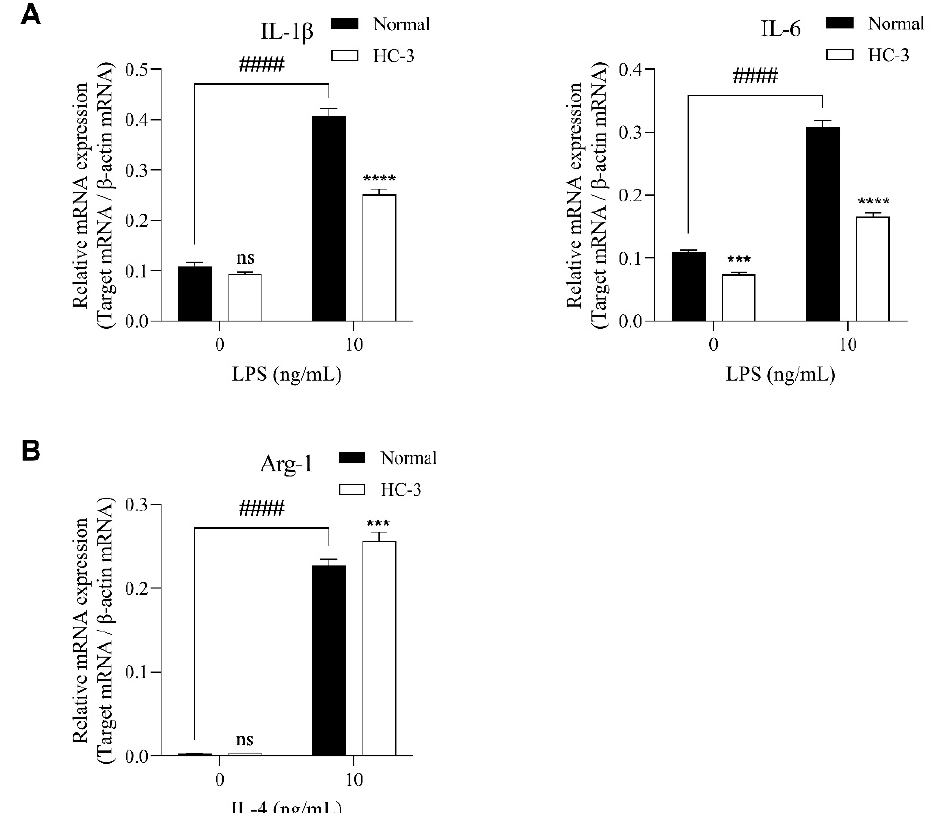
Figure 5. Effects of HC-3 on IL-1 β , IL-6, and Arg-1 mRNA expression in SIM-A9 cells stimulated with LPS or IL-4. ( A ) Expression of IL-1 β and IL-6 mRNA in M1 microglia stimulated with LPS for 4 h in the presence and absence of 1 mM HC-3. ( B ) Expression of Arg-1 mRNA in M2 microglia stimulated with IL-4 for 4 h in the presence and absence of 1 mM HC-3. Relative expression is shown as the ratio of target mRNA to β -actin mRNA. Data are presented as the mean ± SD ( n = 3). *** p < 0.001, **** p < 0.0001 compared with normal medium. Data were analyzed with the Šídák’s multiple comparisons test. #### p < 0.0001 compared with vehicle control. Data were analyzed with the unpaired t -test. ns: no significant difference.